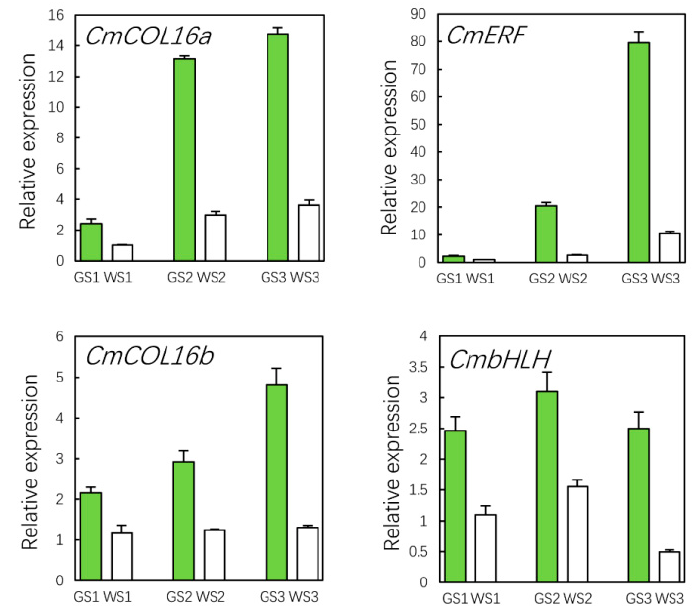
Figure 9. qRT-PCR analysis of hub genes in green and white pools at different stages of flower development.